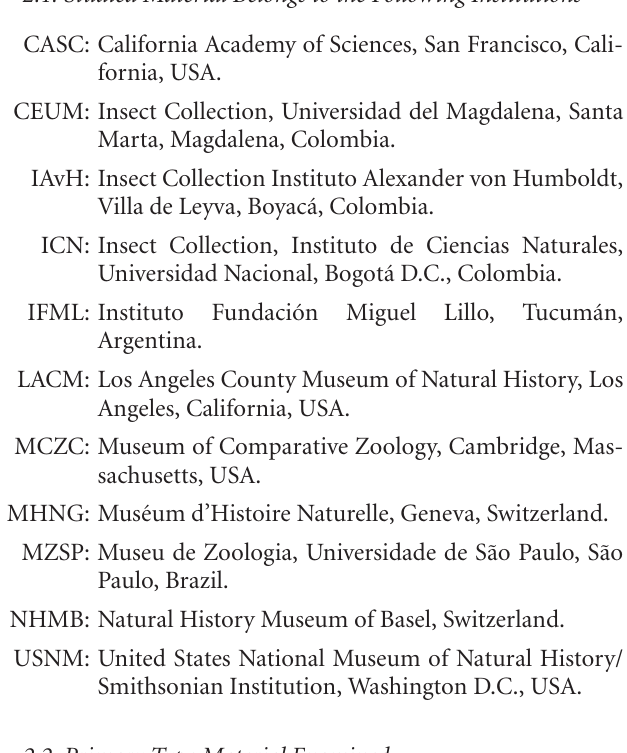
F. Bekker leg. Ex Manihot esculenta , COLOMBIA: